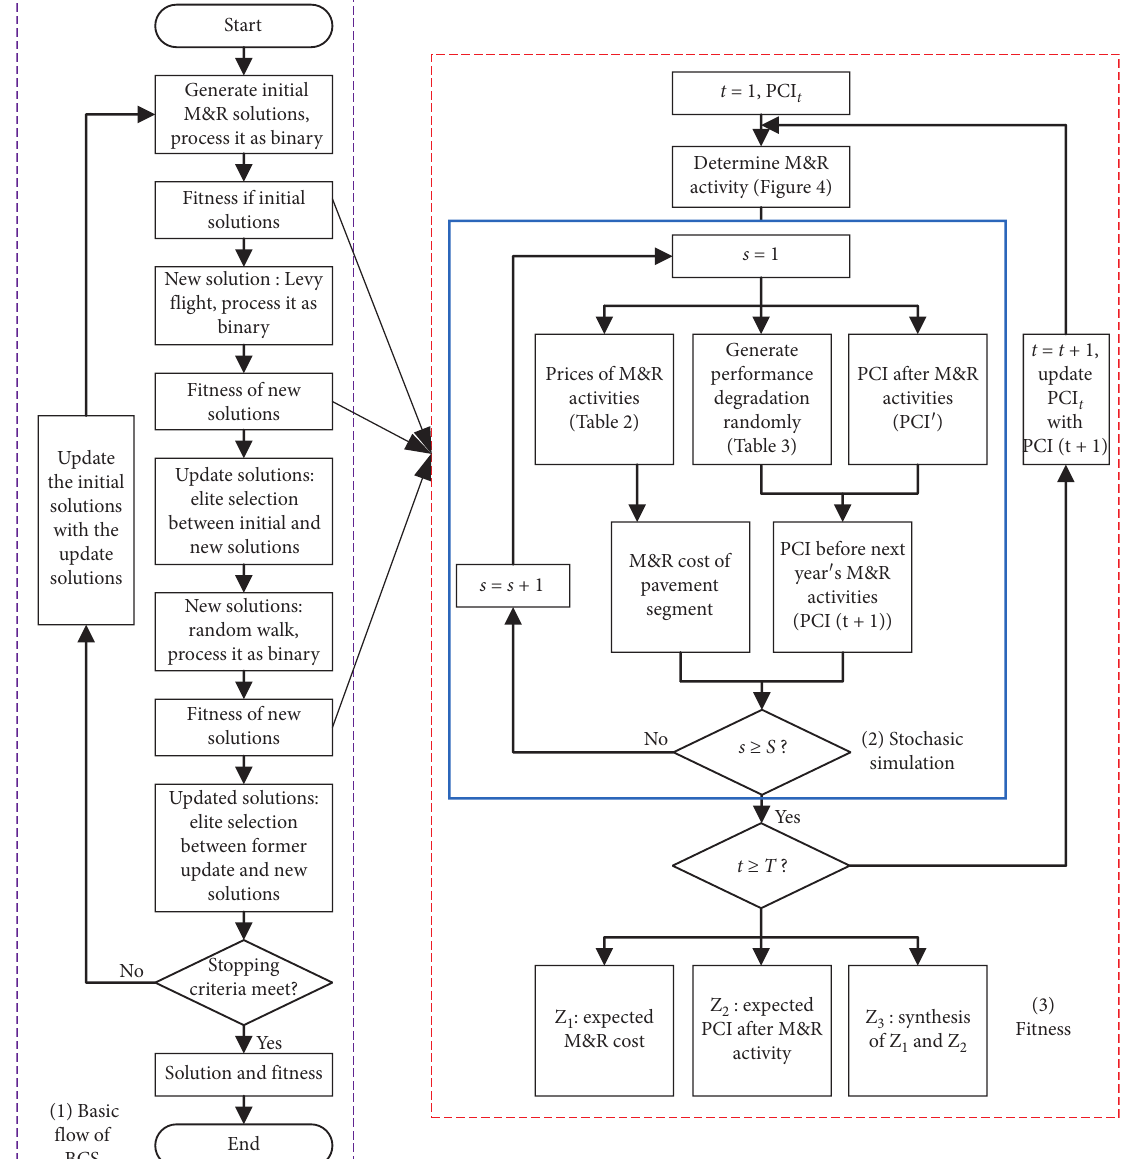
Figure 3: Binary cuckoo search (BCS) framework. S represents number of sample points, and T is the planning